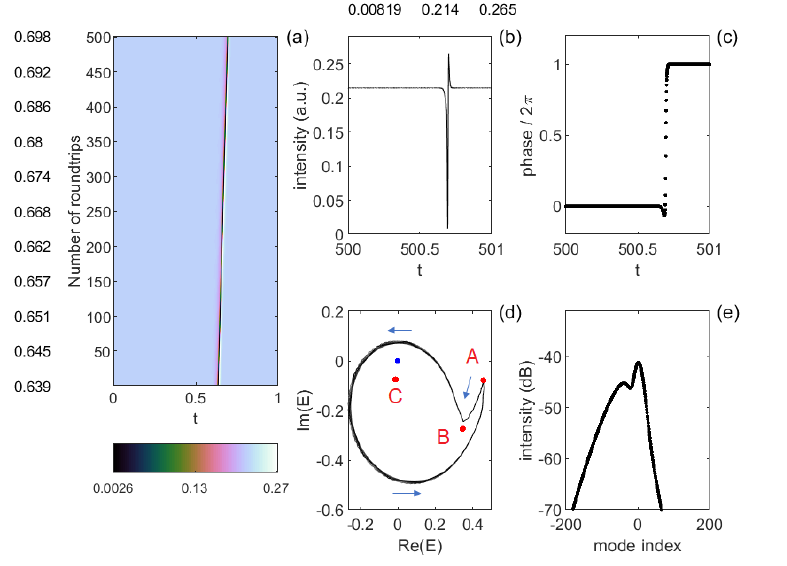
Figure 5. ( a – e ) Same as Figure 2 but with b = 100. The phase soliton is narrower and